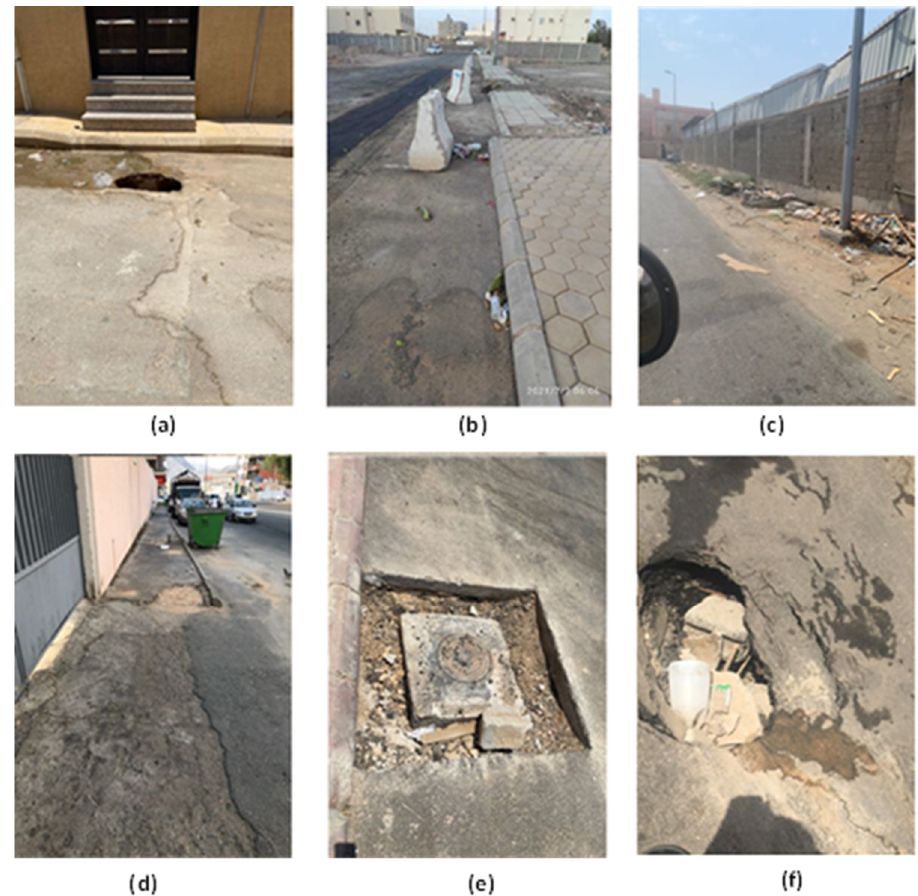
Figure 1. Examples of the three categories central to this study: ( a , b ) represent the barrier category, ( c , d ) illustrate the sidewalk category, and ( e , f ) depict the pothole category. All RGB images were collected from Saudi Arabia.